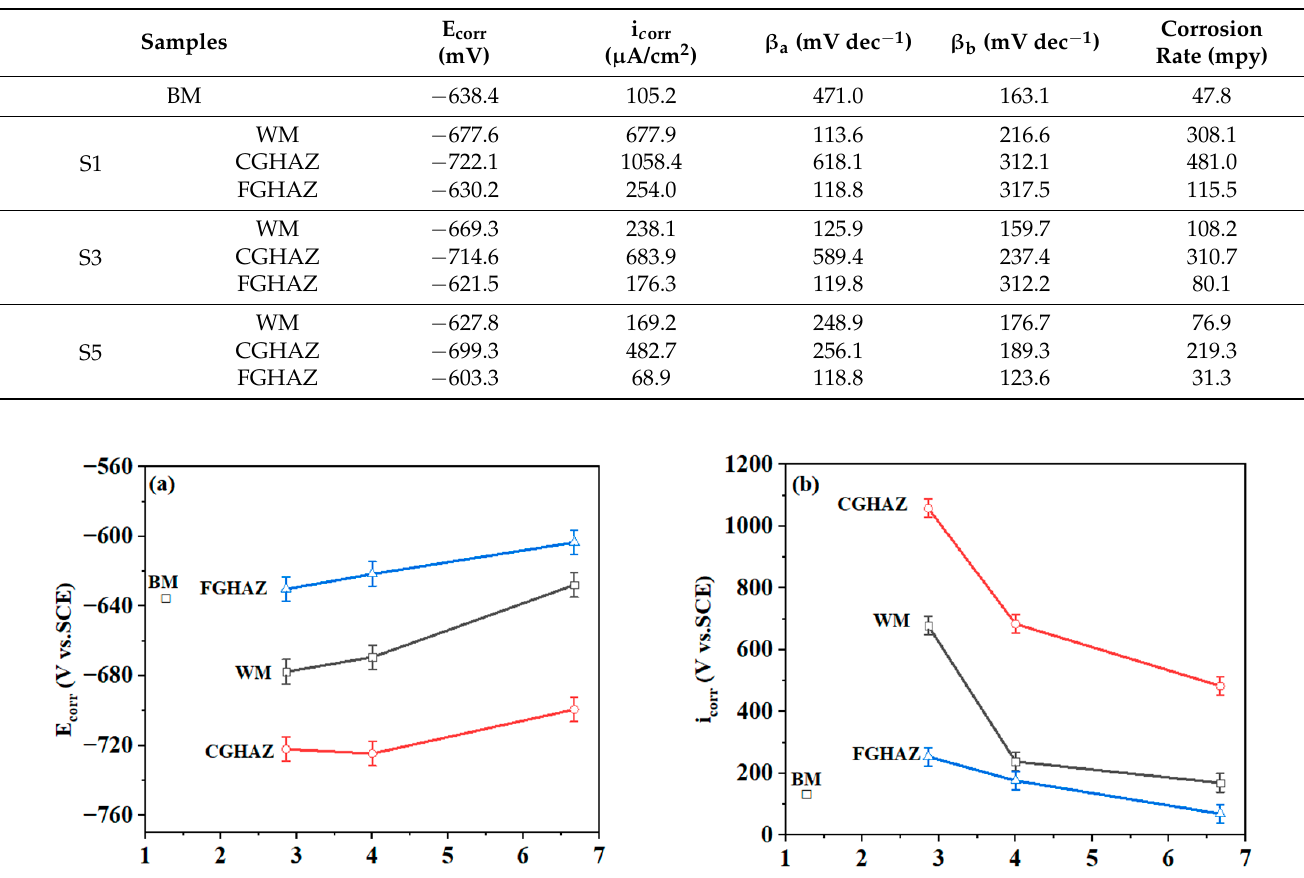
Table 3. Electrochemical parameters fitted from polarization curves.